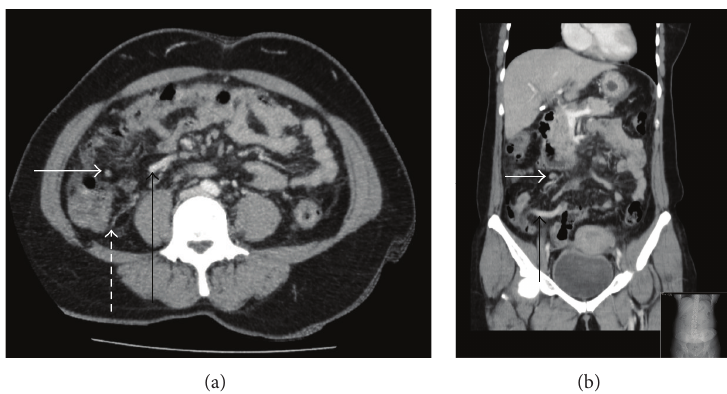
Figure 1: (a) Axial CT with intravenous contrast. The appendix is seen anterior to the right psoas muscle belly and is with a little surrounding free fluid (solid black arrow). Increased attenuating soft tissue in the right paracolic gutter suggests free fluid or secondary peritoneal metastases (broken arrow). (b) Coronal section of the same patient demonstrating the enhancing appendix medial to the caecum. Mural enhancement is commonly seen in appendicitis. However, in this case, there is little surrounding fat stranding and no fluid filled lumen is seen; these features are more atypical. Enlarged lymph nodes are seen in the mesentery (solid white